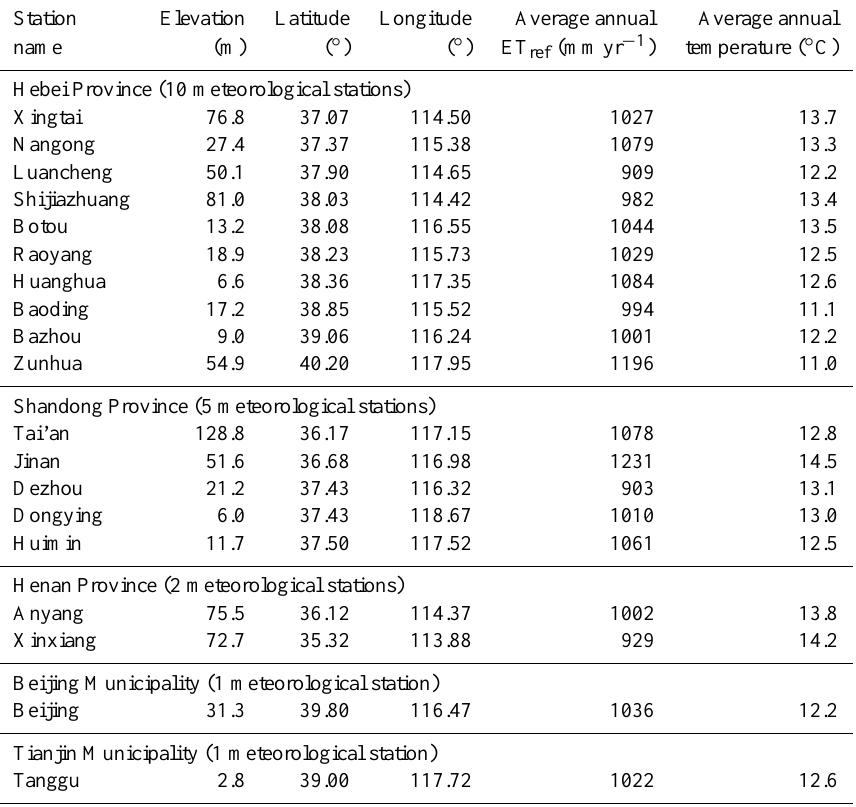
Table 2. Location and elevation information of the meteorological stations (Chinese Meteorological Data Service; Shu, 2010). The average annual reference ET and temperature of each station are also listed here.